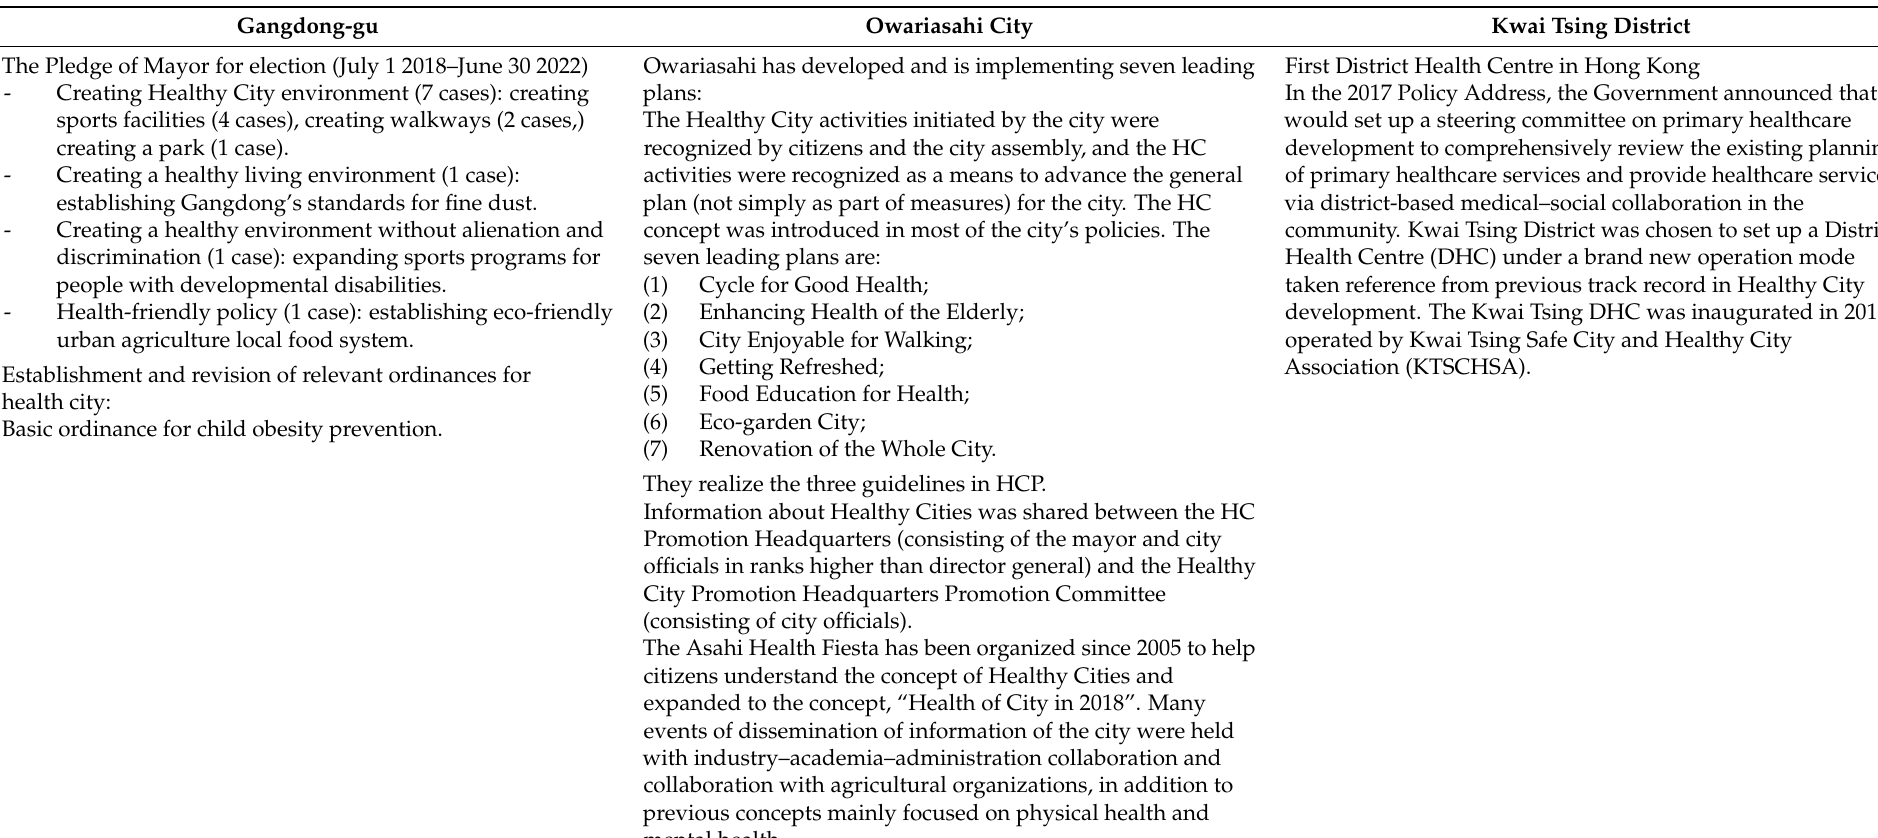
Table 3. Policy commitment and Community